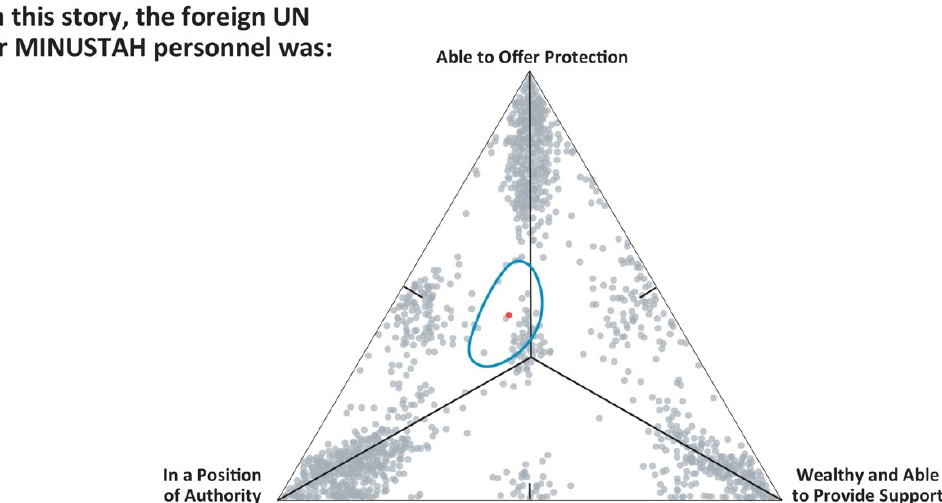
Figure 3. Aggregated geometric mean for Triad 2: In the story, the foreign UN or MINUSTAH personnel was (i) in a position of authority, (ii) able to offer protection, or (iii) wealthy and able to provide support.